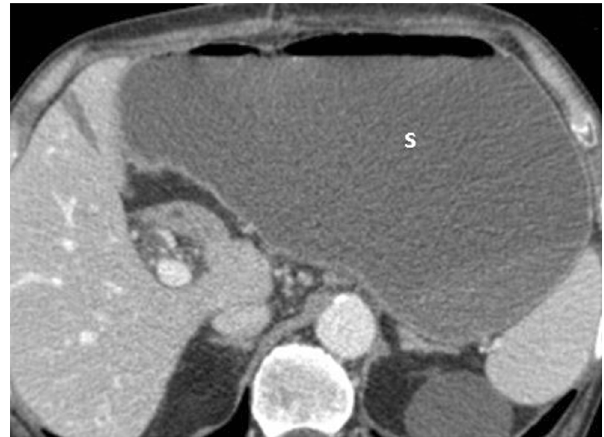
Fig. 17 Axial CT image. A severely distended stomach filled with fluid and air is evident